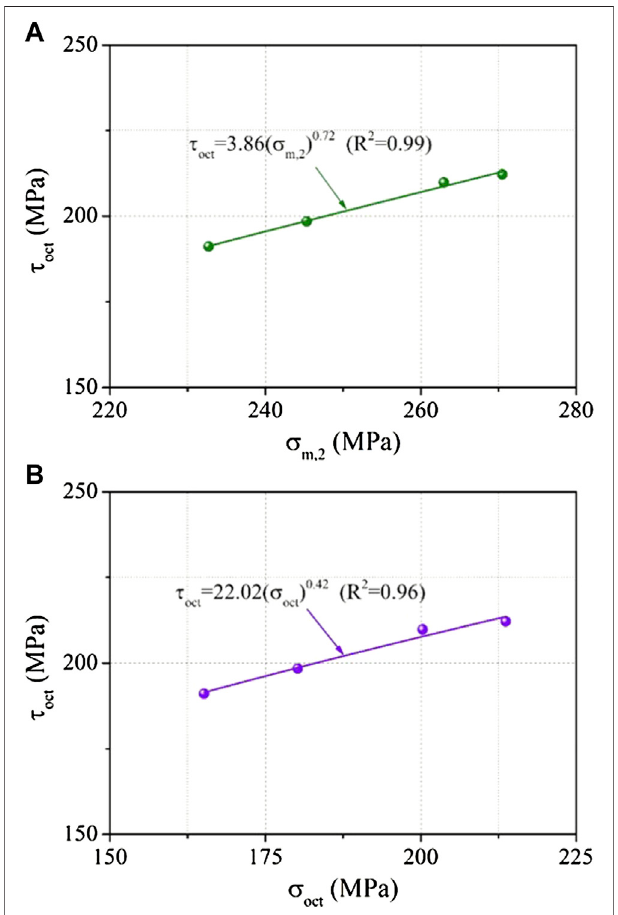
FIGURE9| Truetriaxialcompressionstrengthfortested graniteinterms of (A) τ oct versus σ oct and (B) τ oct versus σ m,2 .